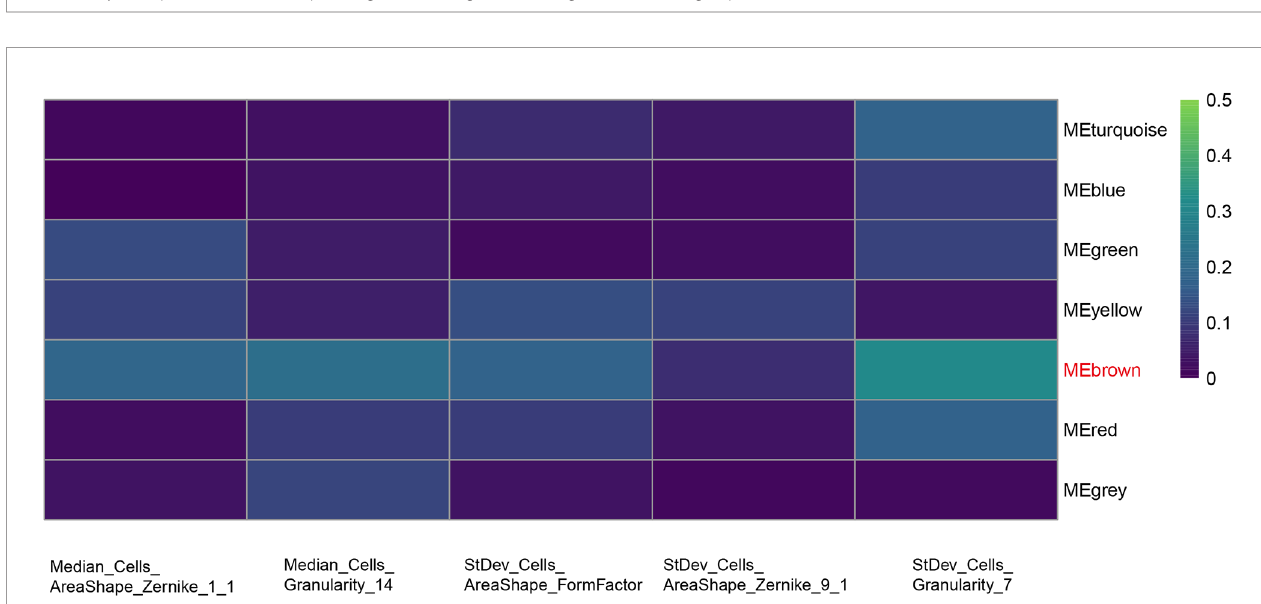
FIGURE 3 | Example of selected histopathological sub-images in both high- and low-risk groups.